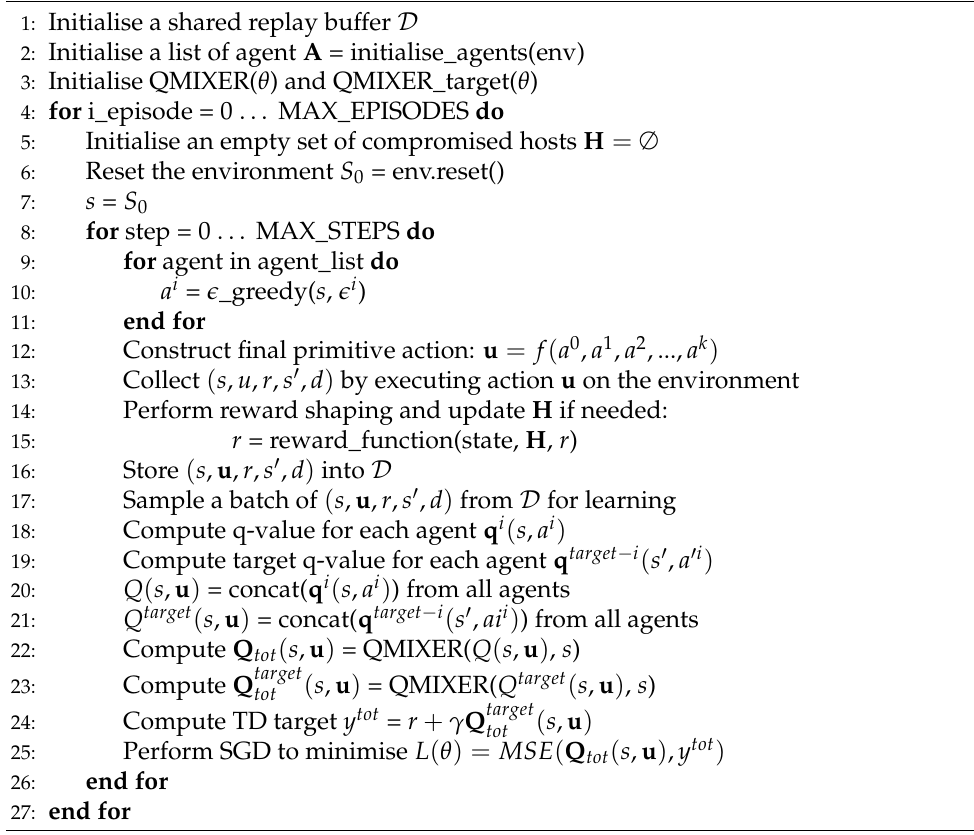
Algorithm 1 CRLA—Cascaded Reinforcement Learning Agents